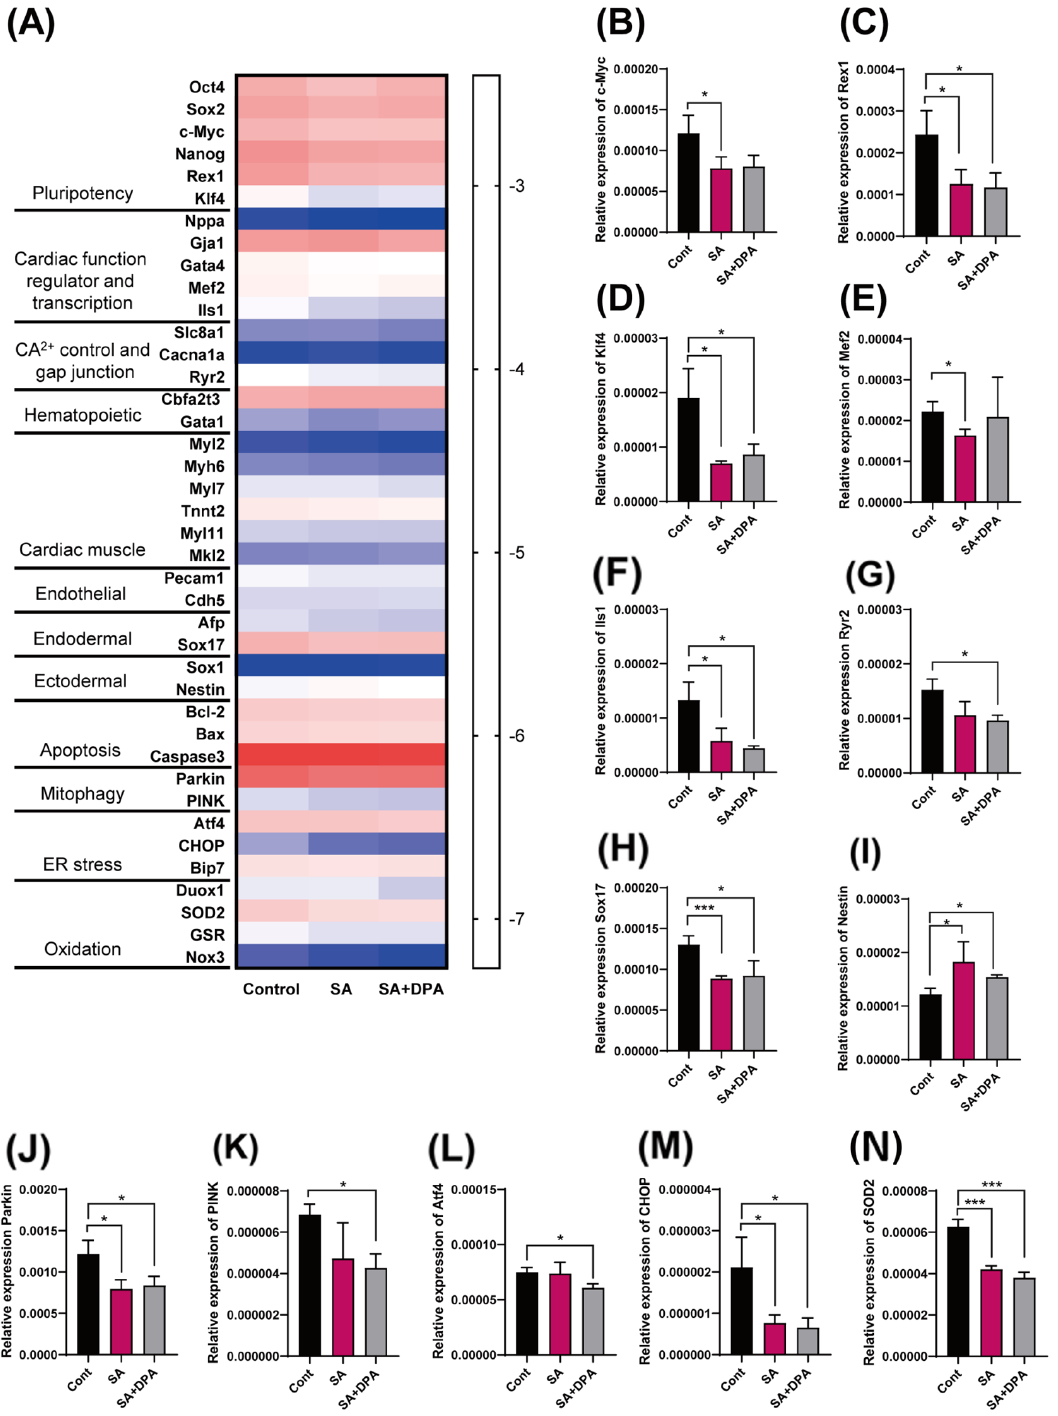
Figure 5. Changes in cardiac differentiation and cell survival-related gene expression levels. The transcription levels of 40 genes were measured in EB after either the SA-only treatment or the SA/DPA co-treatment with SA for four days by real-time polymerase chain reaction (qRT-PCR). ( A ) Heat map for the logarithmic scale of expression levels of comparing 40 genes. ( B – N ) are bar graphs of the relative expression level of the genes, which changed significantly. Significance was obtained using a student’s t -test. * p < 0.05, *** p < 0.001 vs. control. Each value is expressed as the means ± SD. n = 3, Cont; control, SA; sodium arsenite, DPA;